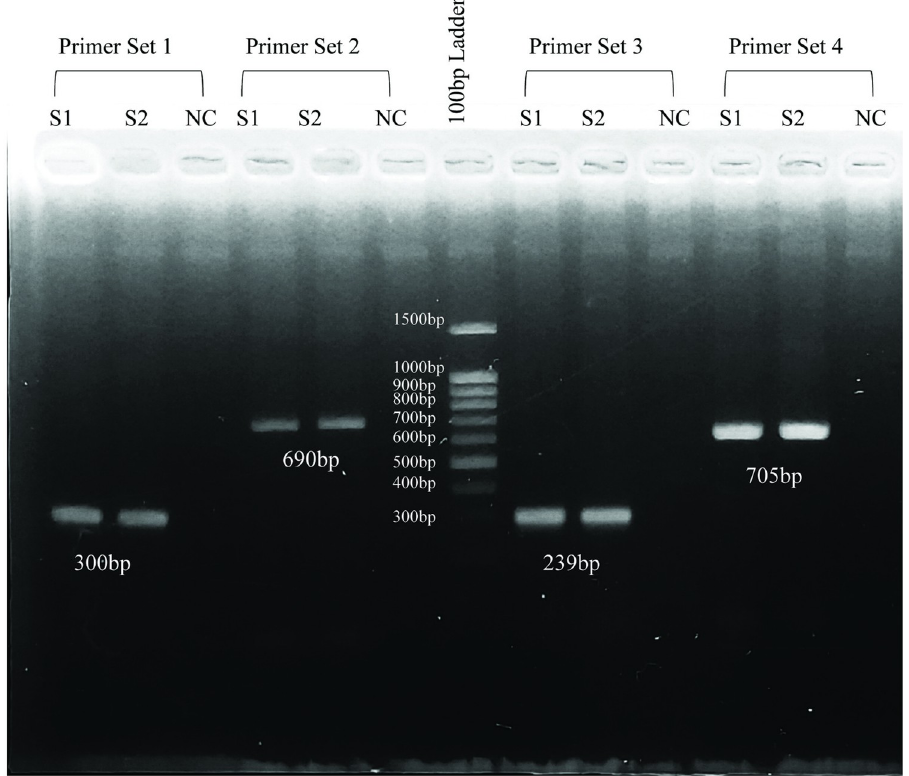
Fig 2. Agarose gel electrophoresis of the amplicons generated from PCR using different primer sets. Primer set 1, 2, 3 and 4 covered the entire coding region of GATA1. For proper estimation of the size of the DNA bands, 100bp ladder DNA was used. S1 = Sample 1; S2 = Sample 2; NC = Negative Control